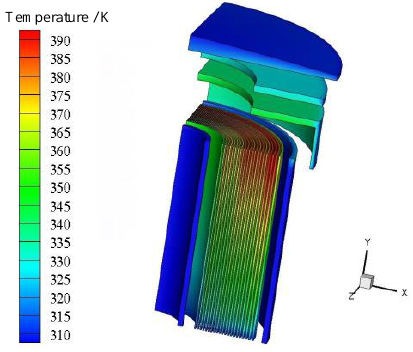
Figure 2. Temperature distribution in the main body of the reactor.